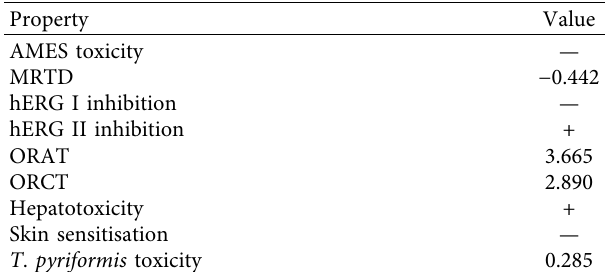
Table 11: Toxicity properties of the alternaramide